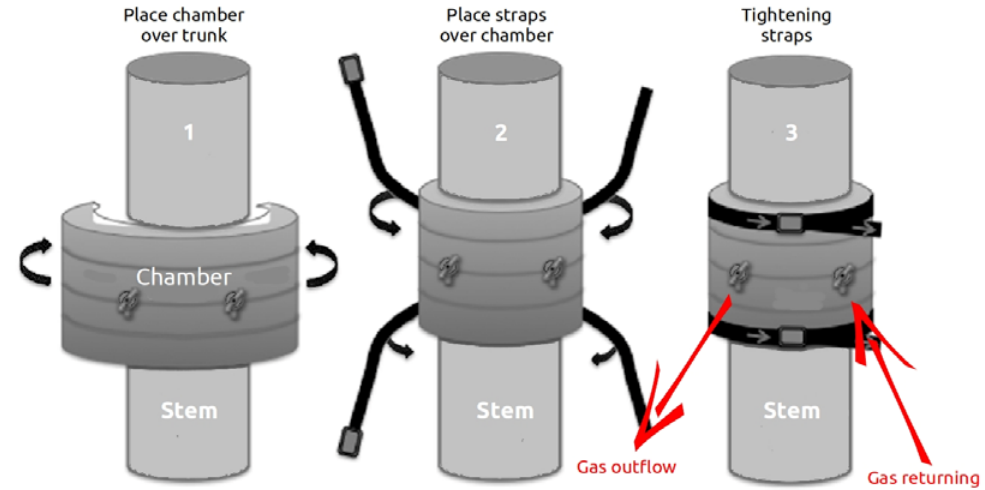
Figure 2. A schematic representation of the gas measurement chamber and its installation on a tree stem.